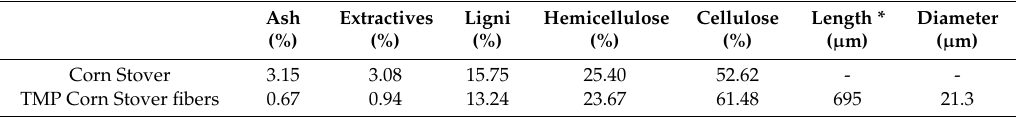
Table 2. Chemical composition of the surface of untreated and thermo-mechanical digestion process (TMP) corn stover.